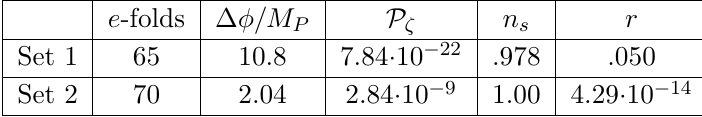
Table 6 . Field range and power spectrum for both parameter sets.